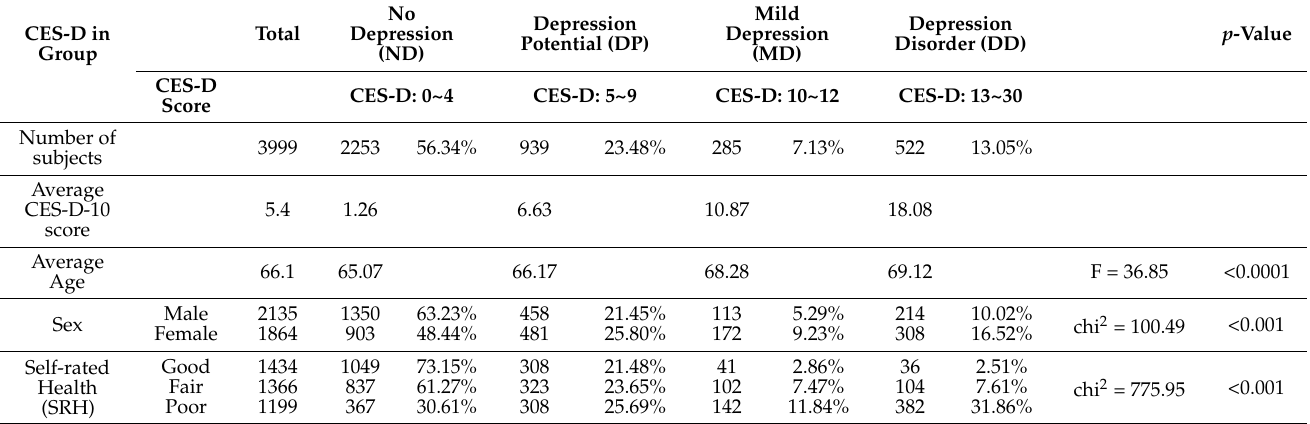
Table 1. Characteristic by Different CES-D Score Groups.